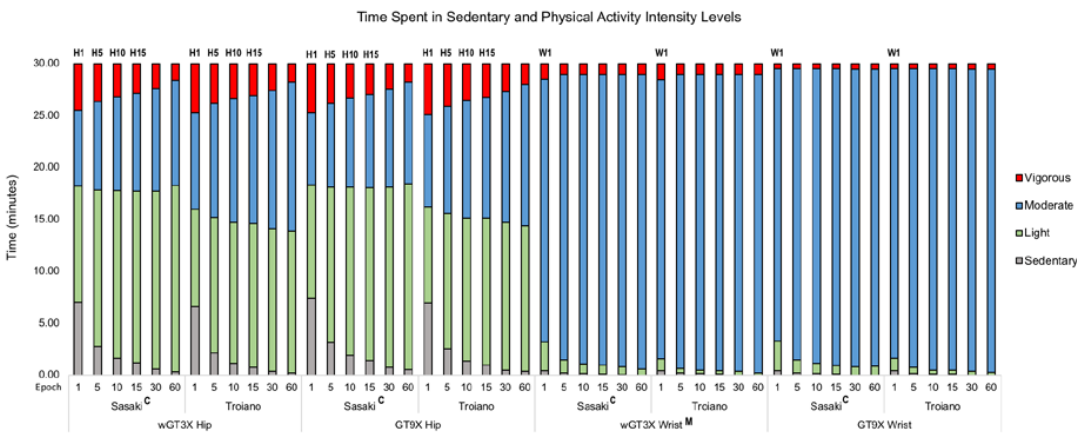
Figure 3. Time spent in sedentary and physical activity intensity levels in epochs. H1 longer sedentary behavior (SB) and shorter light physical activity (LPA) (1 s vs. other longer five epochs: all, p < 0.001) and shorter moderate physical activity (MPA) and longer vigorous physical activity (VPA) (1 s vs.